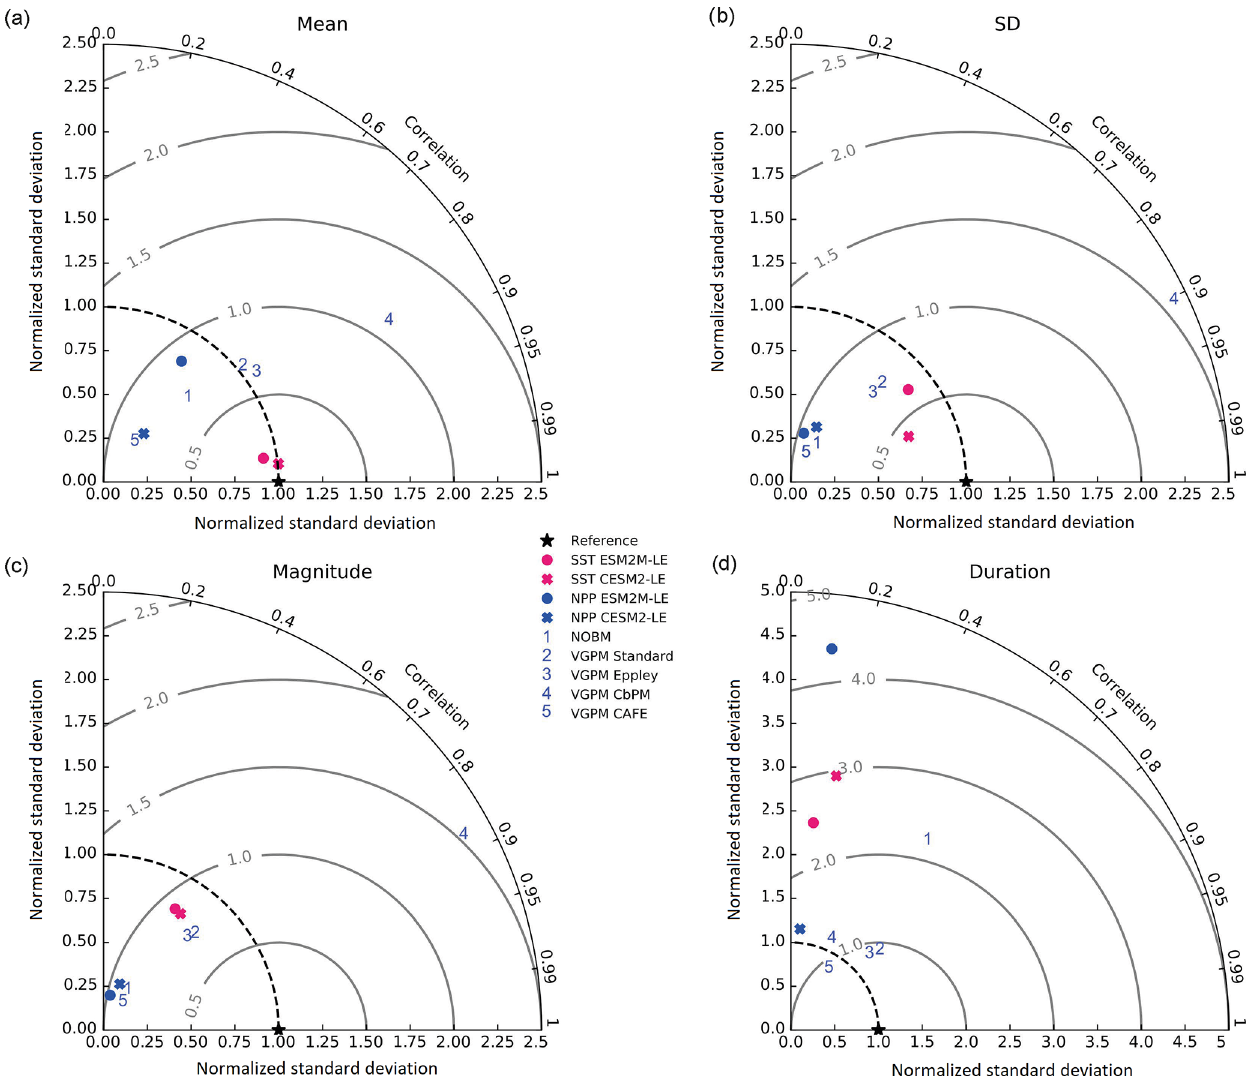
Figure 1. Comparative assessment of the simulated mean and extreme states of SST and NPP and an observed reference. These Taylor diagrams compare the spatial pattern of the climatological mean state (a) and standard deviation (b) of 5d mean SST and NPP, as well as of the magnitude (c) and 90th percentile of the duration (d) of MHWs and NPPX events, simulated by each model to that of a reference. The reference is calculated from the observation-based SST estimate or from the mean of the five different observation-based NPP estimates, and it is indicated by a star on the diagrams. A circle; a triangle; and the numbers 1, 2, 3, 4, and 5 represent ESM2M-LE, CESM2, NOBM, Standard VGPM, Eppley-VGPM, CbPM-VGPM, and CAFE-VGPM, respectively. The Pearson correlation coefficient, which quantifies similarity between the simulated pattern and the reference, is indicated by the azimuthal angle; the centered RMSE in the simulated field is proportional to the distance from the star on the x axis; and the standard deviation of the simulated pattern is indicated by the radial distance from the origin. All statistics are normalized by the standard deviation of the